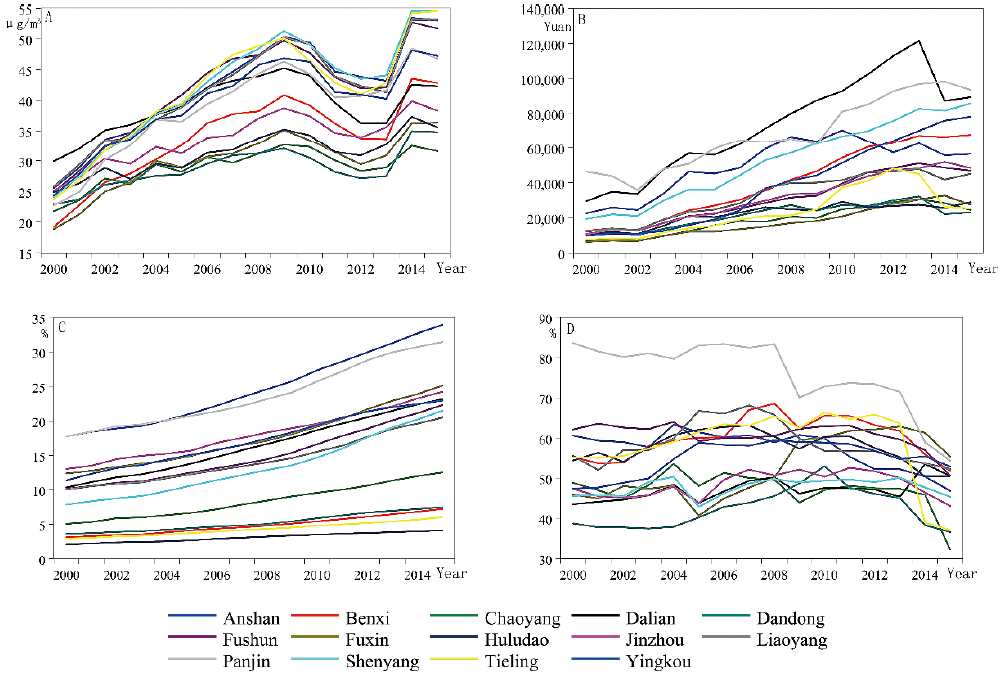
Figure 4. Data of PM 2.5 concentrations ( A ), GDP per capita (GDPPC) ( B ), proportion of urban impervious surface area (UIS) ( C ) and the value added by industry as a percentage of GDP (IND) ( D ) of fourteen cities in the panel that changed over the time series from 2000 to 2015.3.2. Panel Unit Root Test Results.